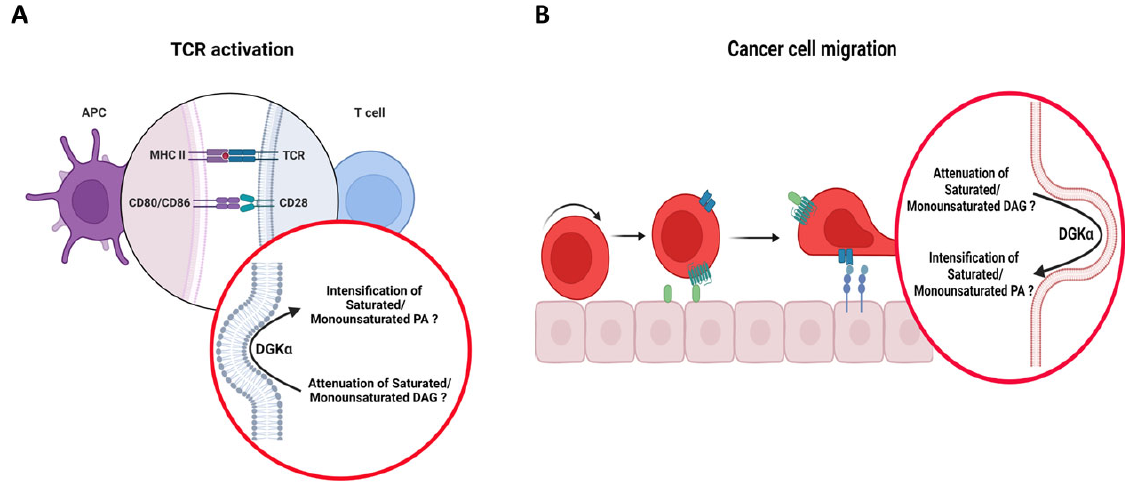
Figure 5. Putative role of DGK α in bridging membrane morphological changes to specific molecular species of DAG/PA in T cell and cancer biological processes. Cartoons illustrating ( A ) TCR activation and ( B ) cancer cell migration. It is proposed that in these processes, DGK α would localize in membranes bearing negative curvature (around the IS during TCR activation and the tips of invasive protrusions during cancer cell migration), which would endow the enzyme with its acyl chain specificity, letting it act on its preferred substrates, i.e., DAG with saturated/monounsaturated acyl chains. Schematic representations were generated using Biorender (©BioRender ‐ biorender.com).